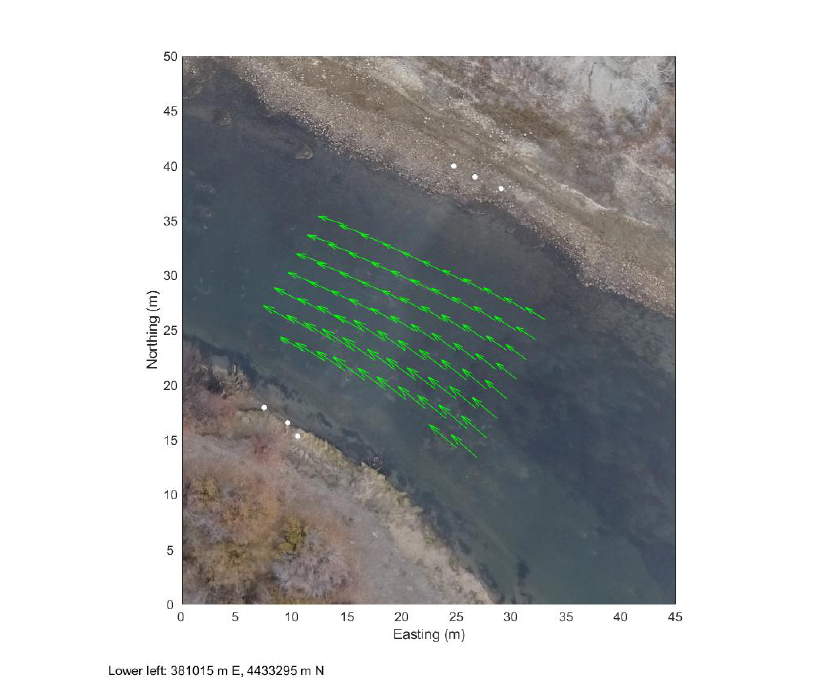
Figure 3. PIV-derived velocity vectors for cross section